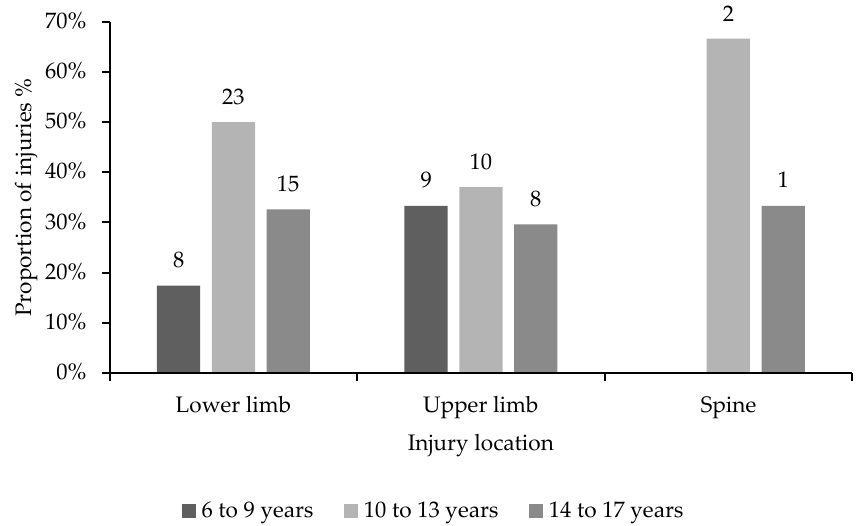
Figure 1. Proportions of lower limb, upper limb and spine injuries distributed across three age categories, with the absolute numbers of lower limb, upper limb and spine injuries in each age cate- gory .